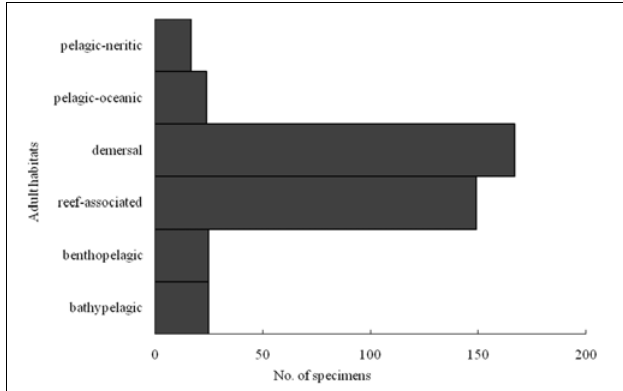
FIGURE 4 | Number specimens of larval fish identified by COI sequences in case I according to adult habitat